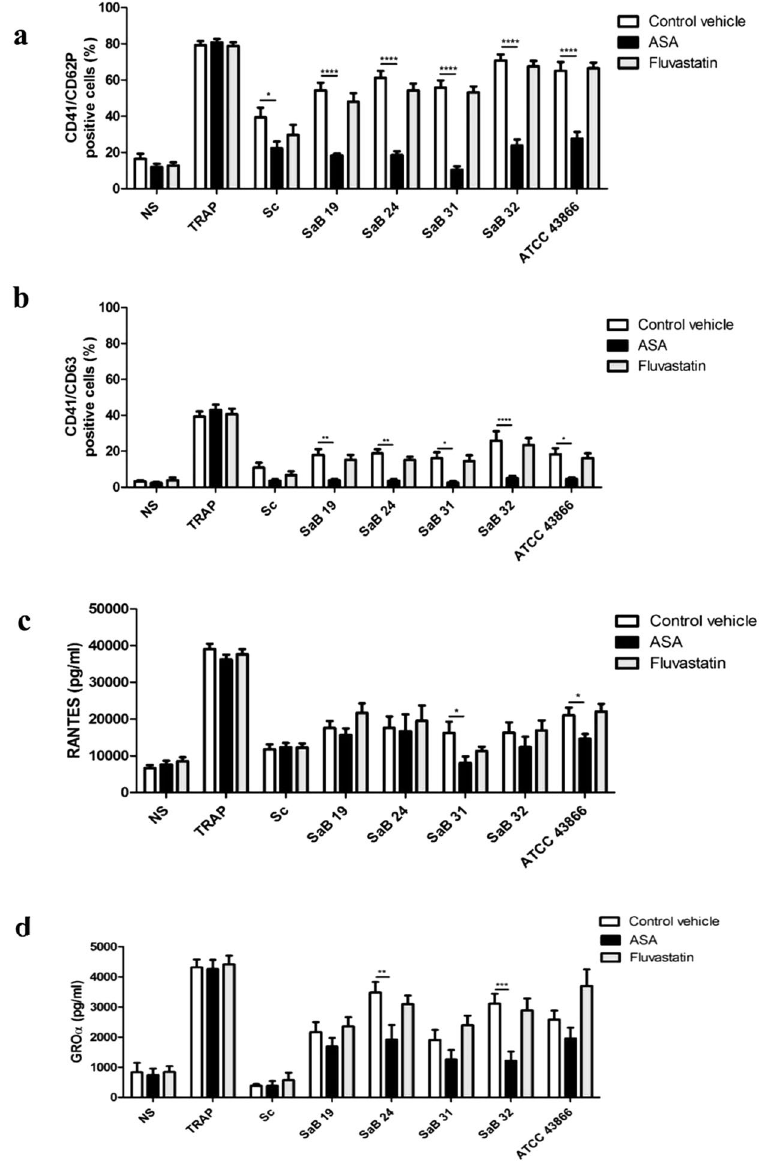
Figure 7. Effect of ASA and fluvastatin on S. aureus -induced platelet activation. Expression levels of the CD62P (a) and CD63 (b) activation markers and immunomodulatory factor release of RANTES (c) and GRO α (d) by platelets were analyzed after stimulation for 30 min with staphylococcal strains [clinical strains (SaB), S. condimenti (Sc) or S. aureus ATCC 43866 (ATCC43866)] with TRAP (as a positive control) or Tyrode’s buffer (as a negative control, NS), ASA, fluvastatin or water (as a control vehicle). Membrane expression of CD62P and CD63 after gating on CD41 was assessed by flow cytometry, and data (mean ± SEM; n = 10 experiments) are expressed as the percentage of positive cells. Immunomodulatory factor levels were assessed by ELISA or Luminex ® assays, and data (mean ± SEM; n = 14–30 experiments)) are expressed as pg/ml or ng/ml (sCD62P). * p < 0.05; ** p < 0.01; *** p < 0.001, **** p < 0.0001 (two-way ANOVA with repeated measures and the Bonferroni post hoc test; ASA or fluvastatin vs . control